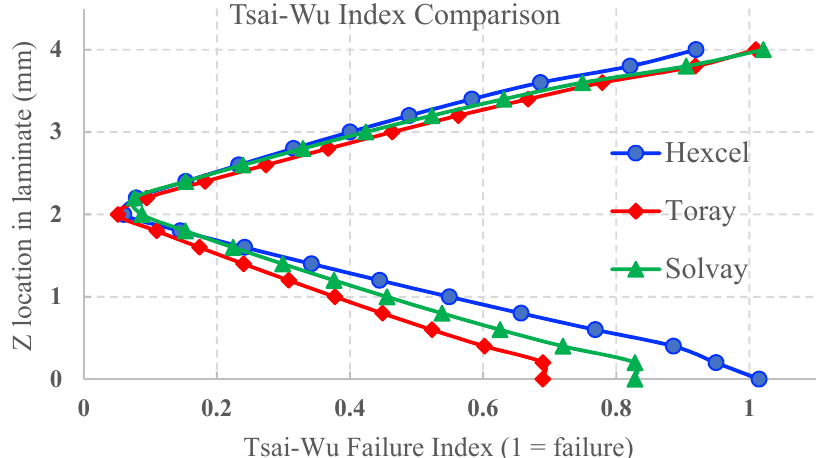
Figure 6. Plotted Tsai–Wu indices across thickness for three systems. Stresses across the thickness near the loading location are plotted and shown in Figure 7. Only stresses for the Toray system were plotted, as all analyzed systems showed similar trends. Shear stresses τ 23 and τ 12 were not plotted, as their values were near zero throughout the thickness, having negligible contribution to laminate failure.